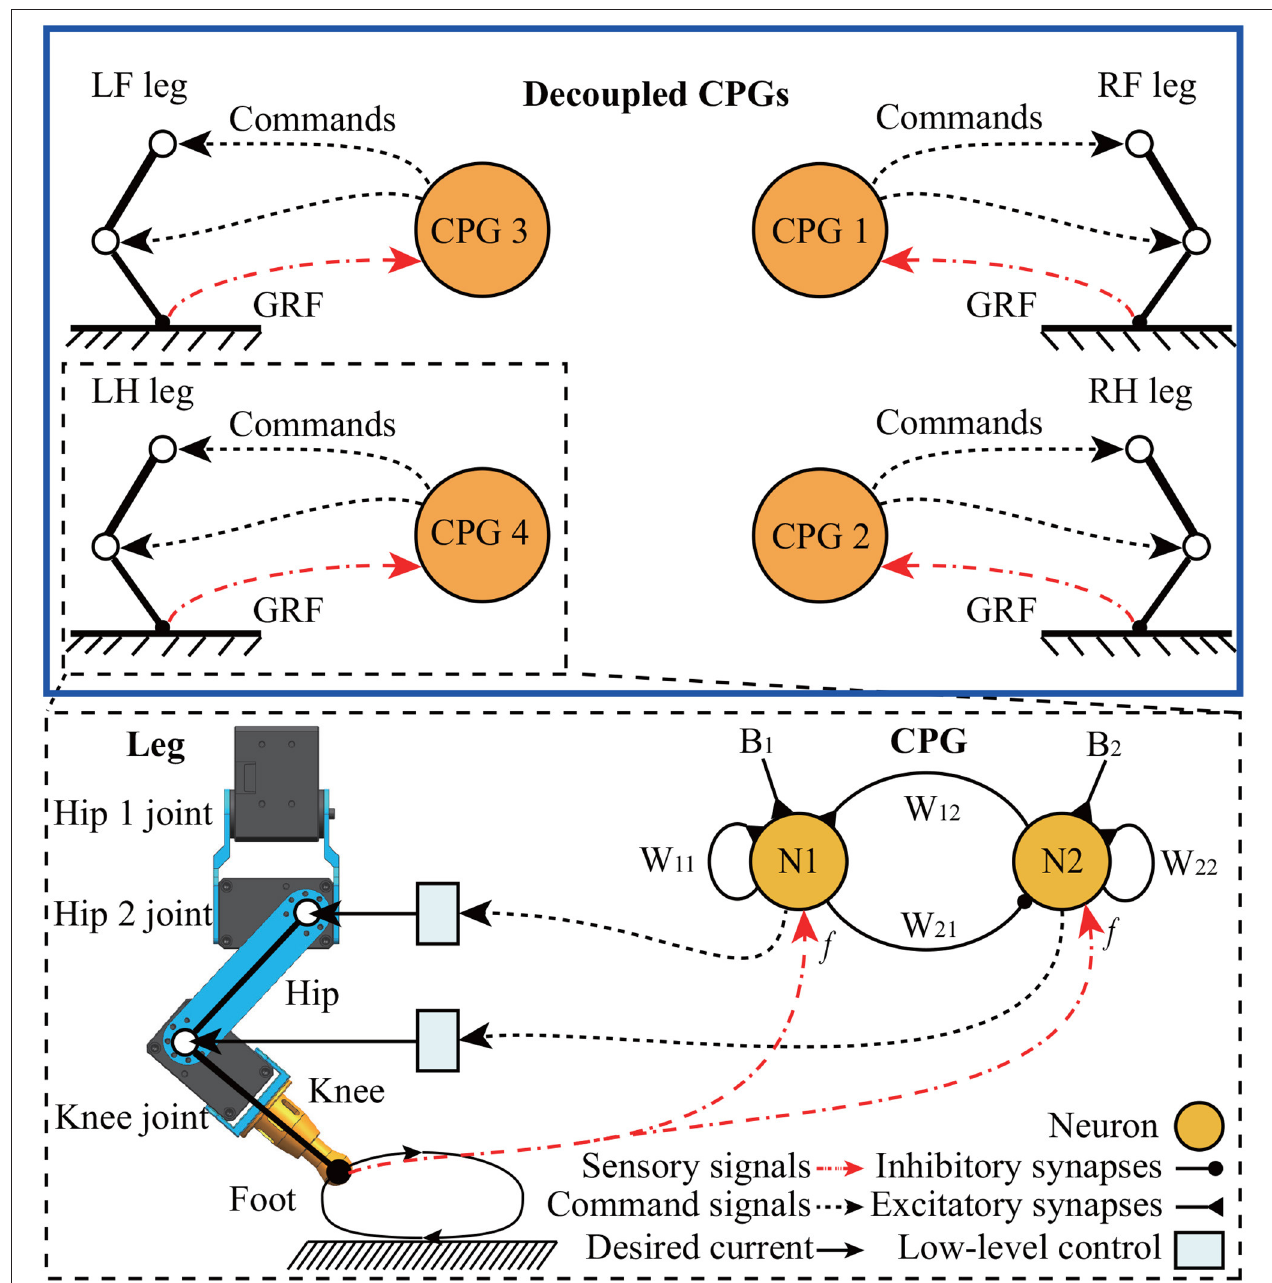
FIGURE 6 | Schematic of decoupled CPGs. Each CPG, which comprises two mutually interactive neurons, obtains a global robot state through the GRF as sensory feedback. The mathematical model of the decoupled CPGs can be seen in the Supplementary Material . The weights and bias terms of the CPG were empirically set to W 12 = 0.21, W 21 = − 0.21, W 11 = 1.4, W 22 = 1.4, and B 1,2 = 0.01 in the following experiments. The details of the parameter setup can be found in Manoonpong et al. (2008).